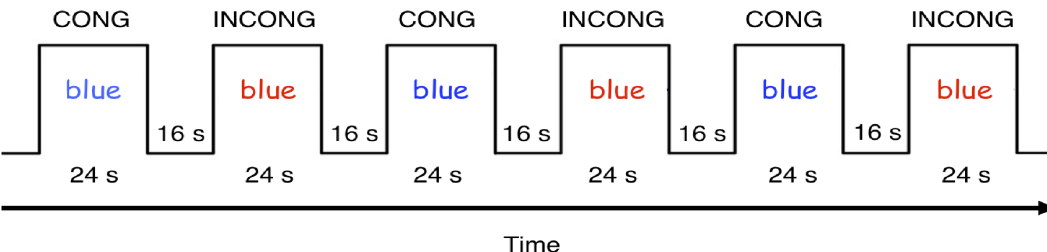
Fig 2. Color-Word Stroop task fMRI paradigm. Exampleof a single scanningsession of the fMRI Color-Word Stroop task. Each run containedsix blocks (three congruent, three incongruent). Each block contained12 trials (1700ms per trial with a 300ms interval between). Each block was followedby a 16 second rest periodfor a total scan time of 240s per